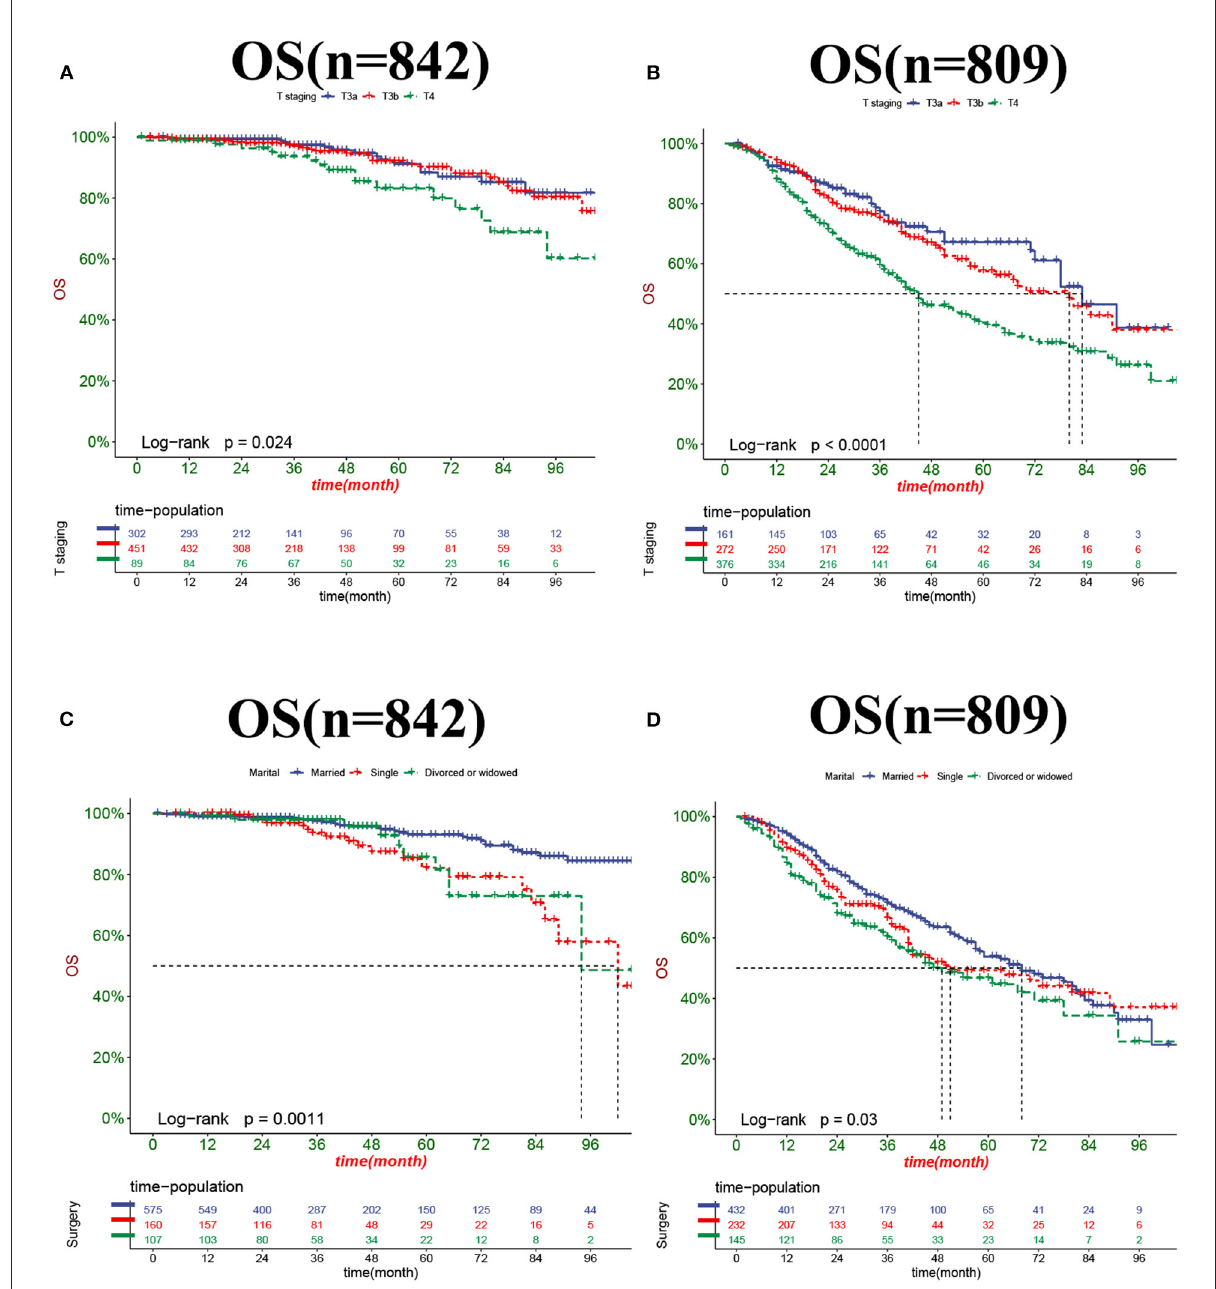
FIGURE8 Kaplan-Meier curves for predicting OS in patients with different T stage (A,B) and marital status (C,D)